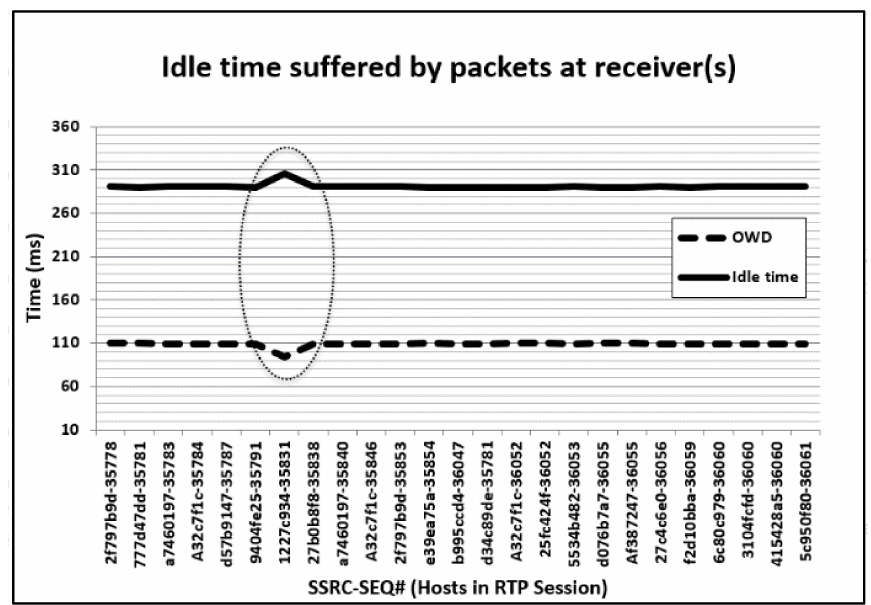
Figure 13. Idle time vs. one-way delay